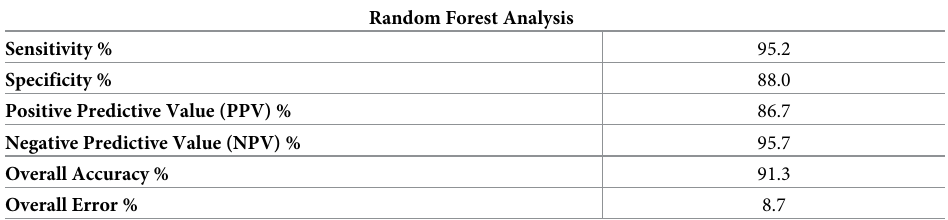
Table 3. Diagnostic results using a panel of 44 AD-driven MCI biomarkers and Random Forest ( RF ).